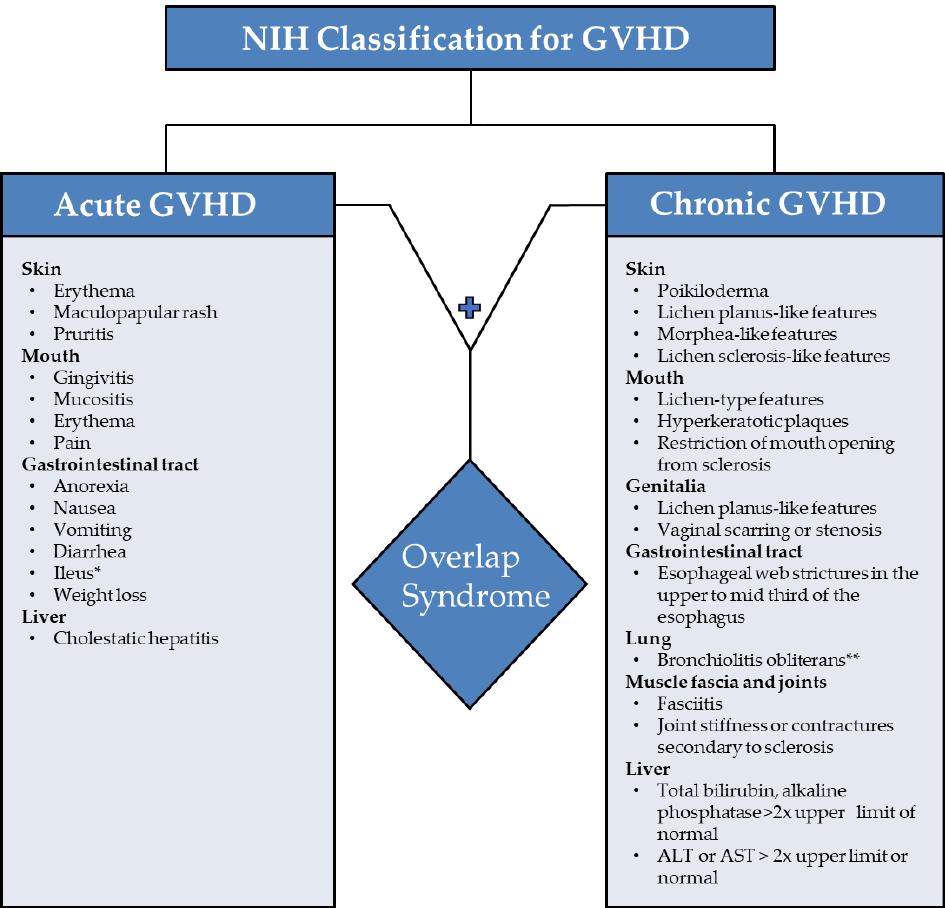
Figure 1. Symptoms of acute and chronic Graft-Versus-Host Disease with overlap syndrome ac- cording to NIH classification [9]. Legend: GVHD indicates Graft-Versus-Host Disease; ALT, alanine aminotransferase; AST, aspartate aminotransferase. * Symptoms specific to acute GVHD; ** Requires biopsy to confirm diagnosis.